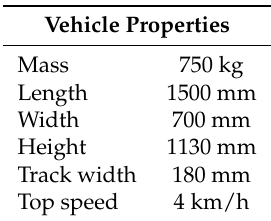
Table 1. Main characteristics of the tracked vehicle.